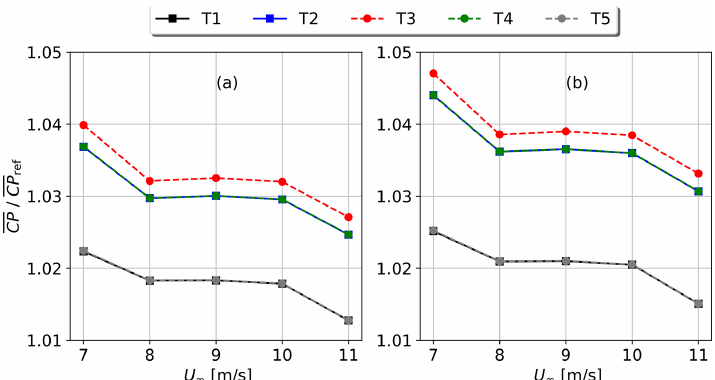
Figure 9. Power coefficient C P of the five turbines in the row averaged over the inflow sector and normalised by the average C P of the isolated turbine for several values of U ∞ and a normal distribution N θ ( µ θ = 0 ◦ ,σ θ = 41 ◦ ) for θ . The free-stream velocity U ∞ is extracted by a virtual met mast (a) and a virtual lidar (b) at a distance of 2.5D from the rotor.